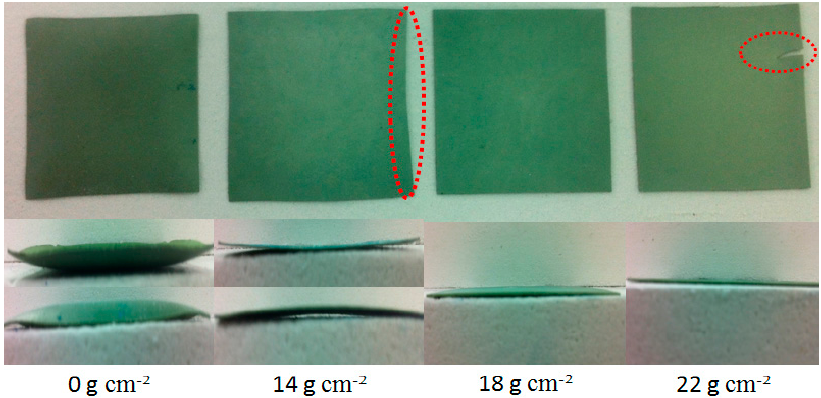
Figure 6. The flatness and deformation of the anode ‐ electrolyte tape with different applied loads.